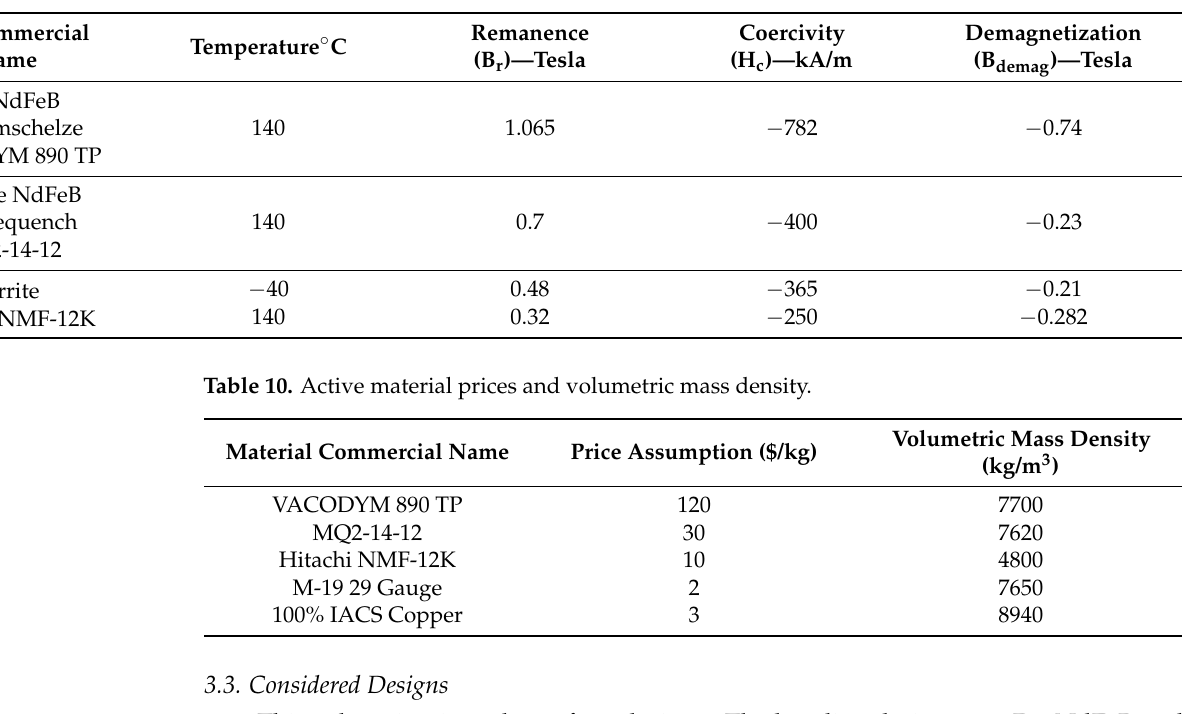
Table 9. PM properties at 140 ◦ C.